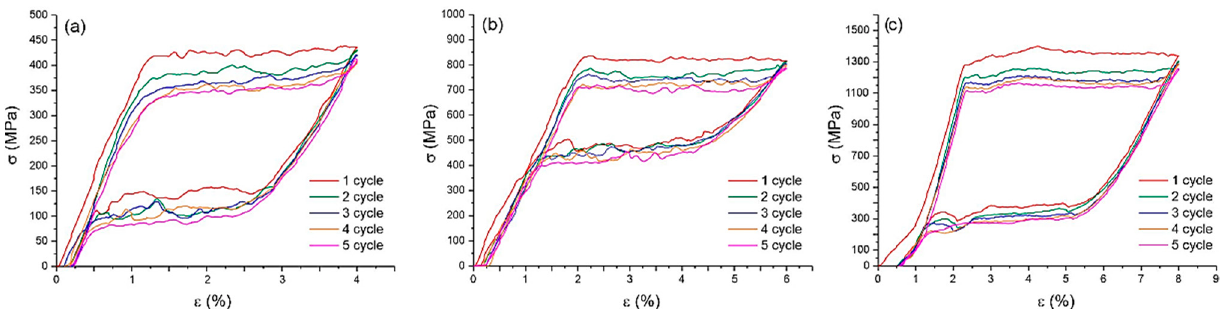
Figure 5. Engineering stress–strain diagrams of cyclic tension of NiTi wires with thicknesses of ( a ) 40 µm, ( b ) 60 µm, and ( c ) 90 µm. ( a ) 40 µ m, ( b ) 60 µ m, and ( c ) 90 µ